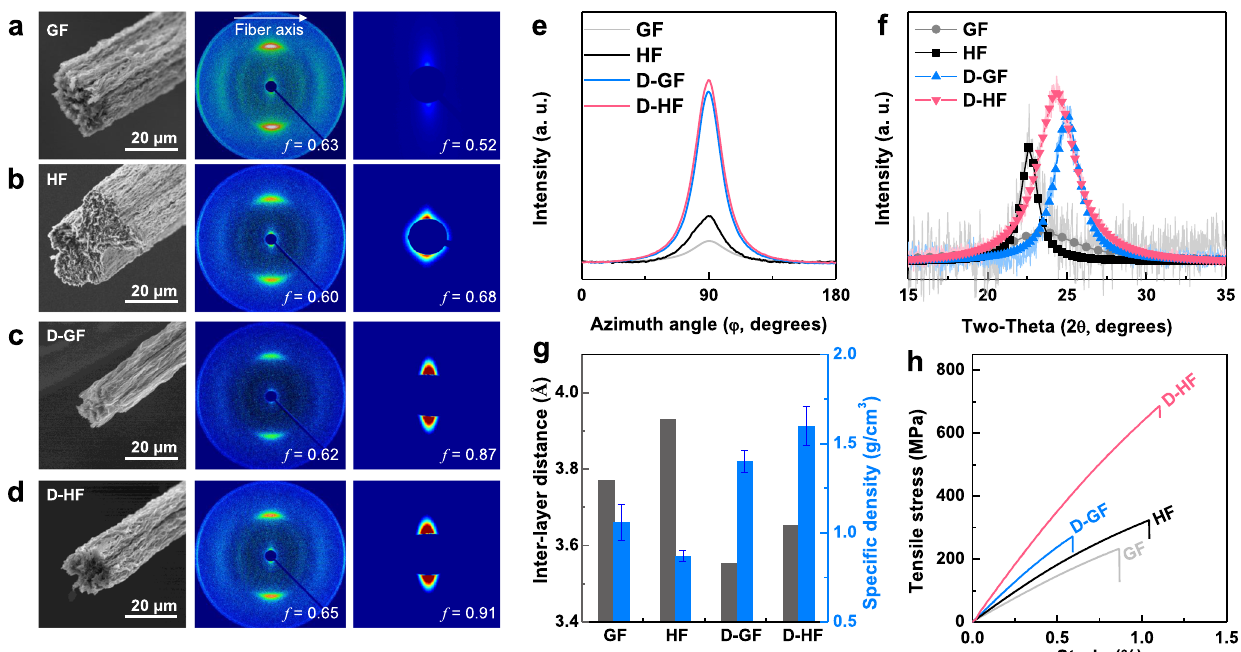
Fig. 2 Highly oriented and compactly integrated structures of fi bers. Morphology, WAXS, and SAXS patterns of a rGO-only fi bers (GF), b hybrid fi bers (HF) prepared without a take-up process (drawing), c rGO-only fi bers (D-GF), and d hybrid fi bers (D-HF) with drawing. e Azimuthal plot representing the Herman ’ s orientation factor from SAXS. f XRD pattern showing the distribution of the inter-layer distances. g Inter-layer distance and speci fi c density. h Tensile stress – strain curve of the fi